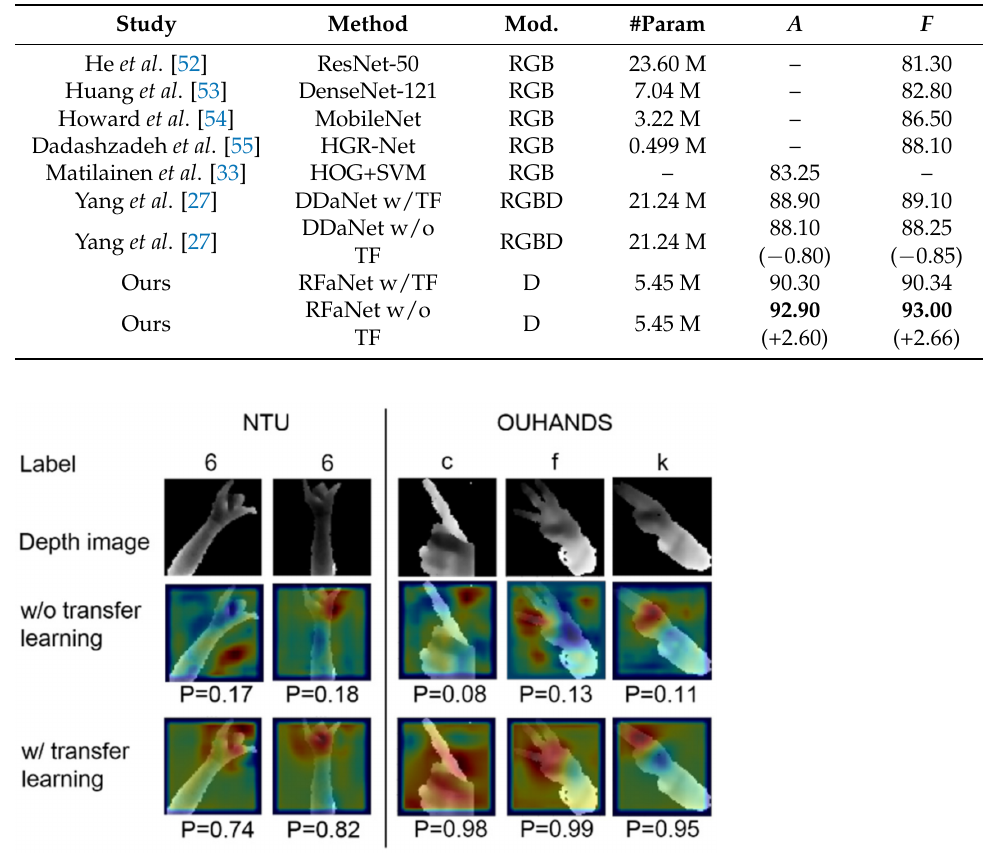
Figure 8. Qualitative analysis of transfer learning on the NTU and OUHANDS datasets where “w/o” and “w/” represent without and with, respectively. The NLRF layer was visualized by Grad-CAM. Transfer learning was implemented by pre-training RFaNet with the ASL dataset and fine-tuning it with the OUHANDS dataset. Because the amount of data in the NTU dataset is 1/3 of that of the OUHANDS dataset, two and three samples were provided for the NTU and OUHANDS datasets, respectively. P is the softmax score of the ground-truth